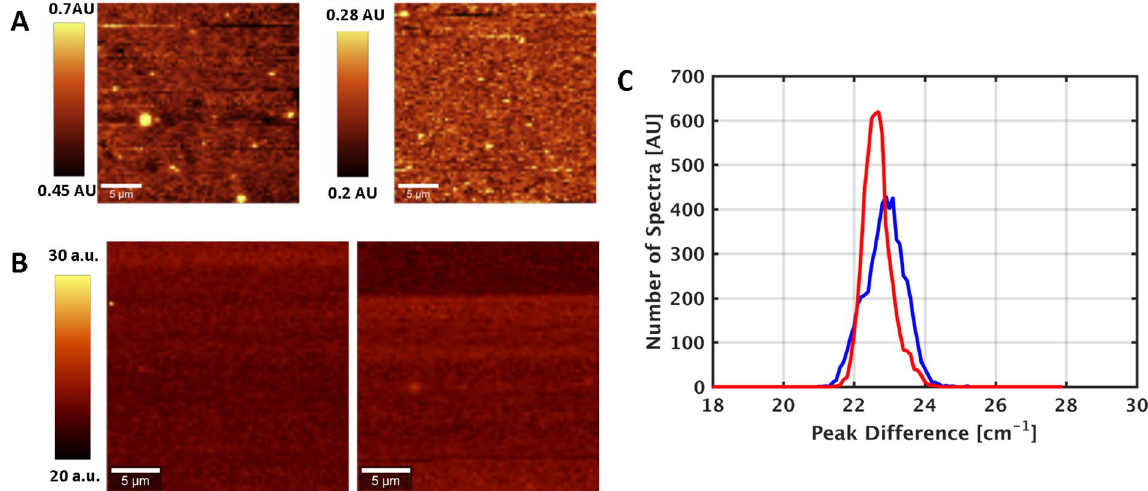
Figure 5. ( A ) Peak intensity ratio of the MoS 2 (E1) peak to silicon mode. ( B and C ) Peak difference map between the A 1g and the E 1 2g peak.